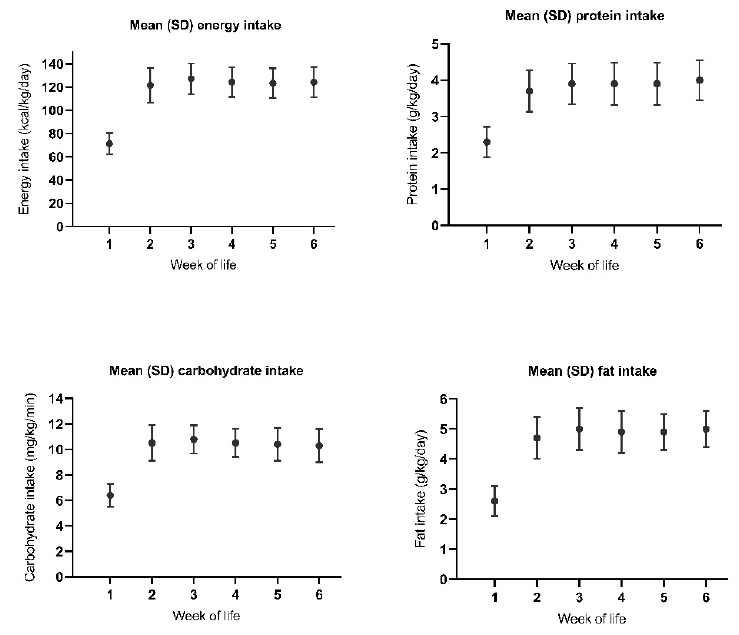
Figure 5. Nutrient intake in preterm infants in the first six weeks of life.